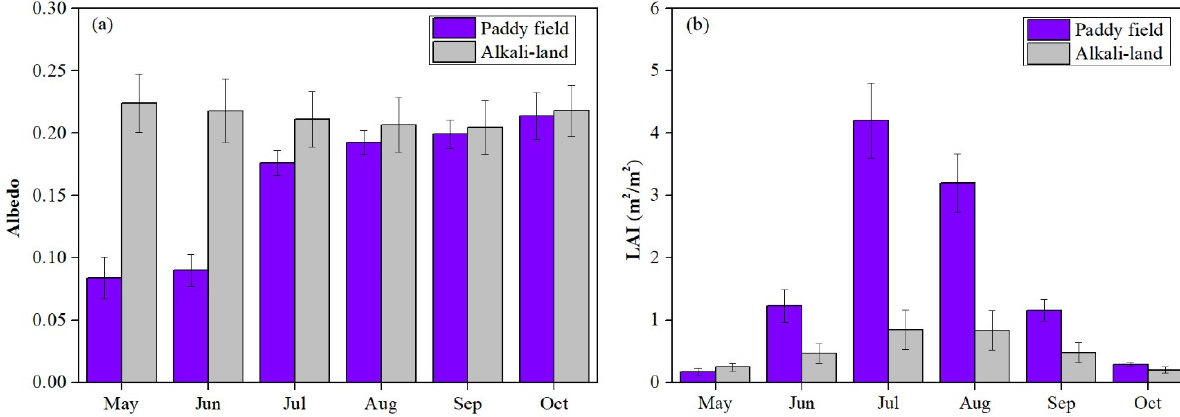
Figure 6. The seasonal variations in albedo ( a ) and LAI ( b ) for paddy fields and saline-alkali land in western Jilin.